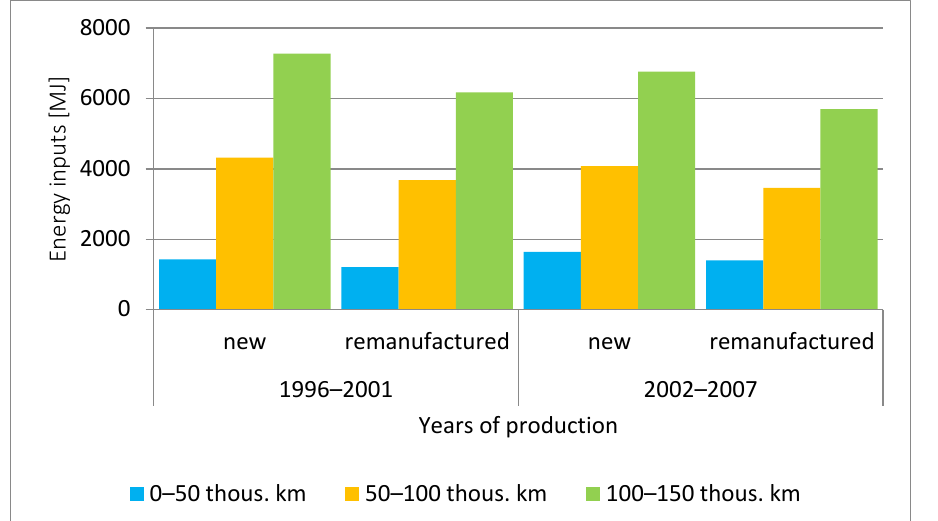
Figure 7. Energy expenditure related to the failure rate of units for new and remanufactured parts in a passenger car depending on its mileage and production period.